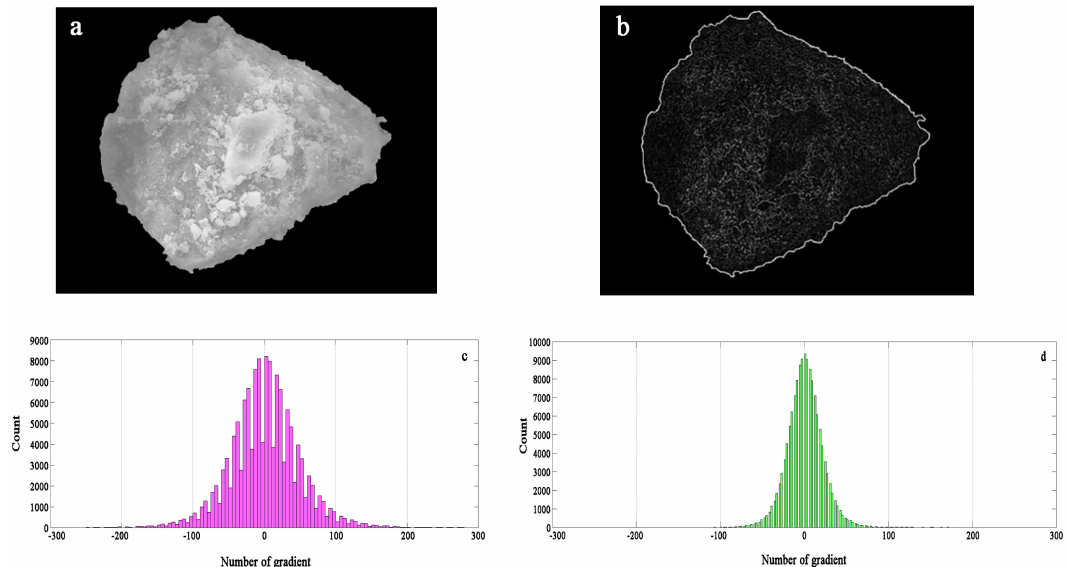
Figure 14. Gradient feature of Laplacian operator: ( a ) original gray scale image, ( b ) vertical gradient feature, ( c ) second-order gradient of Laplacian operator under template a, ( d ) second-order gradient of Laplacian operator under template